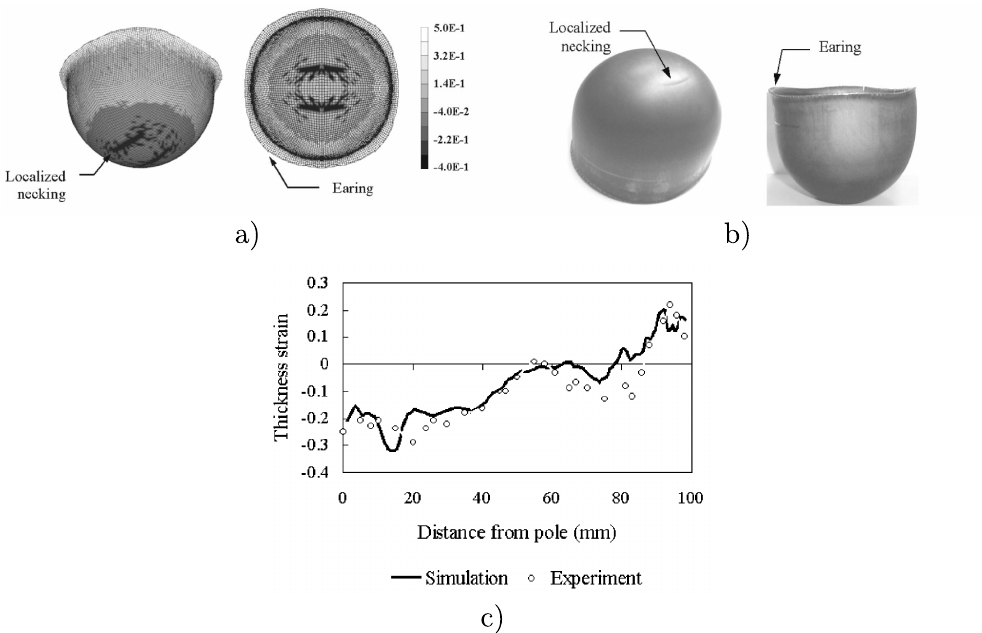
Figure 6. Comparison of the cup drawing between numerical simulation and experiment for CP800 material: ( a ) predicted thickness strain distribution and earing at punch travel 10 mm; ( b ) pho- tographs of experiment specimen; ( c ) thickness strain distribution along the rolling direction. Repro- duced from [172], under